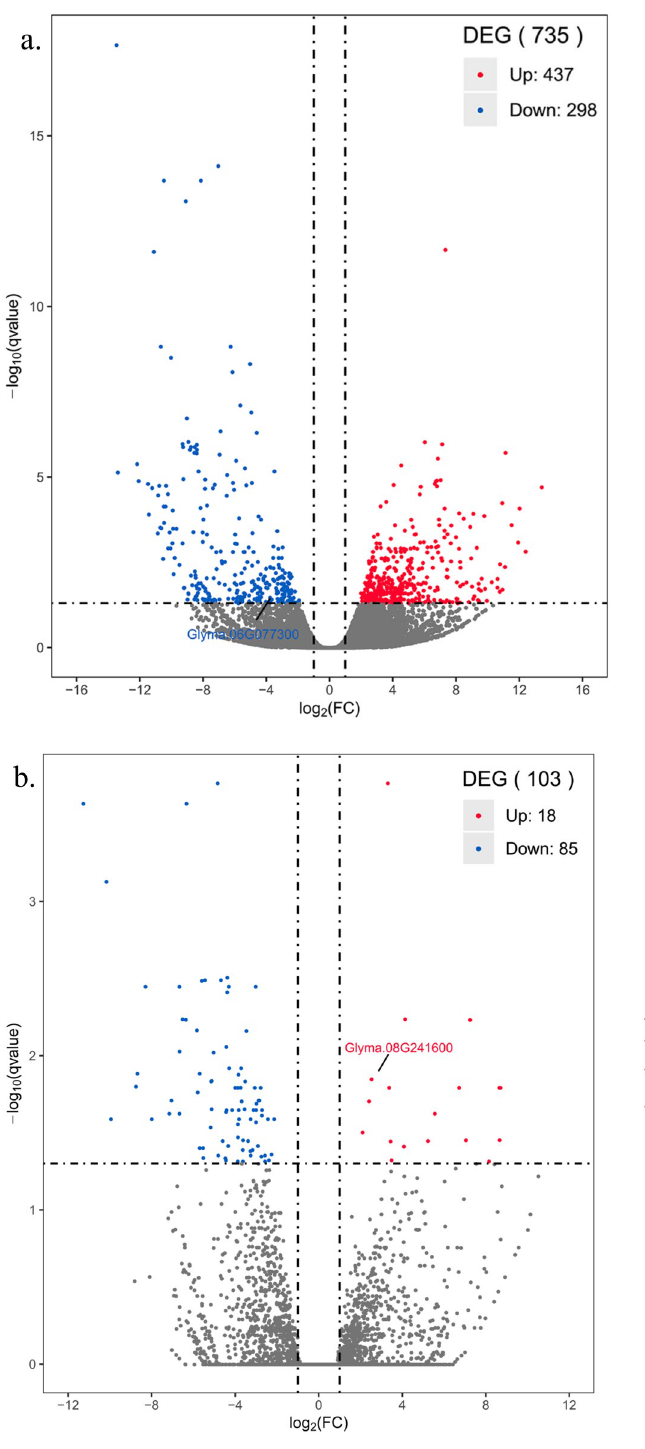
Figure 9. Differences in the transcription levels of G. max genes under disease stress (Upregulated and downregulated genes are indicated in red and blue, respectively. Genes with abnormal transcription levels are marked in the figure. ( a , b ) represent differences of gene transcription levels between days 3, 7 and blank control, respectively, after disease stress, and ( c ) represent differences of gene transcription levels between days 7 and 1 after disease stress).